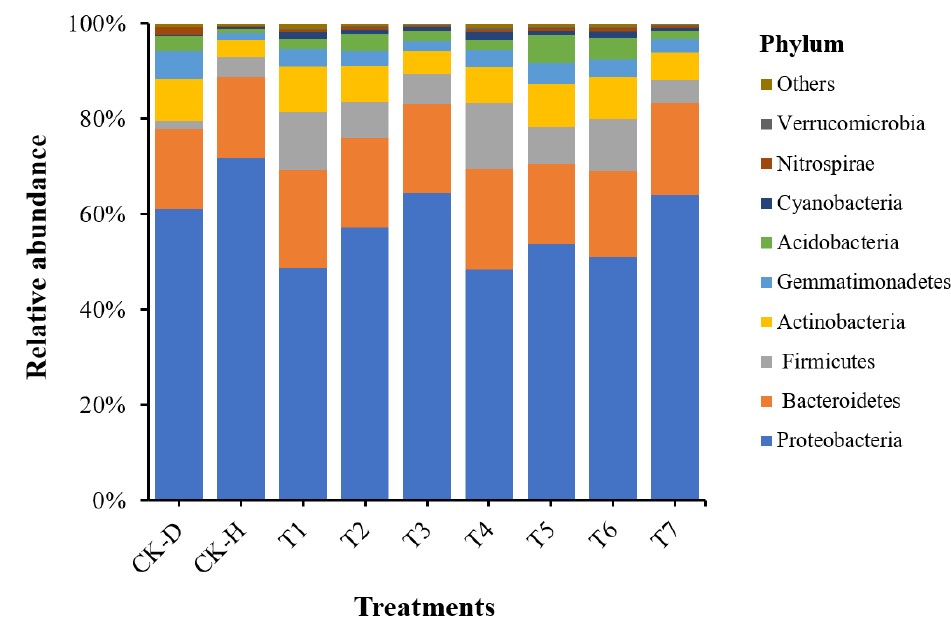
Figure 4. Relative abundance bar plots for 10 most dominant bacterial phyla under different treat- ments (n = 3/treatment). Disease control (CK-D), healthy control (CK-H), single-strain Lysobacter antibioticus 13-6 (T1), single-strain L. capsici ZST1-2 (T2), single-strain Bacillus cereus BT-23 (T3), intra- genus co-culture of L. antibioticus 13-6 + L. capsici ZST1-2 (T4), inter-genus co-culture of L. antibioticus 13-6 + B. cereus BT-23 (T5), microbial consortia B. cereus BT-23 + L. antibioticus 13-6 + L. capsici ZST1-2 (T6), and commercial fungicide Kejia (T7).